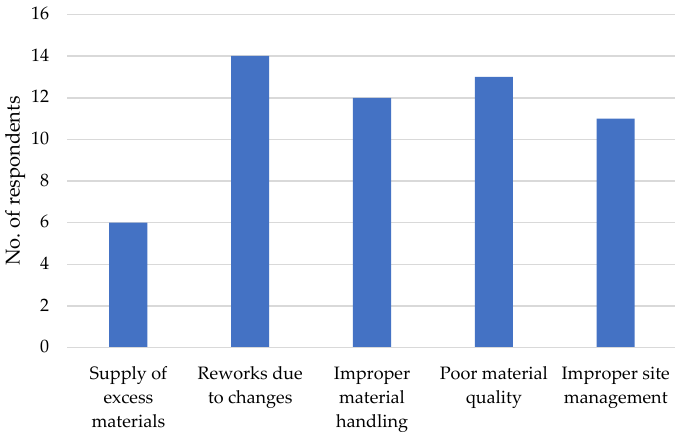
Figure 9. Survey responses on the causes of C&D waste generated at the sites.